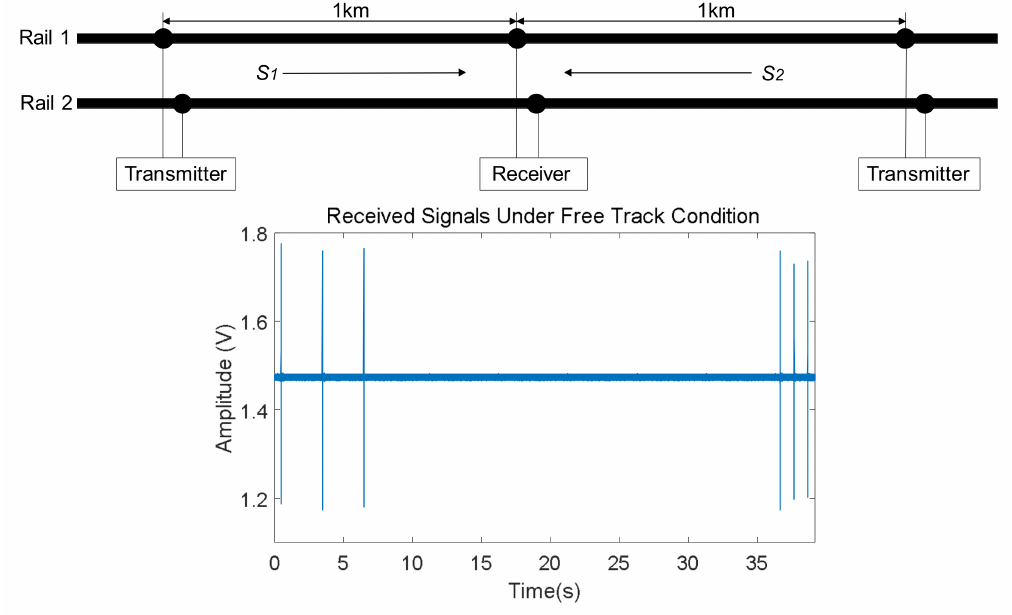
Figure 5. Example of a reception in rail no. 2 including both signals S 1 and S 2 for a free track